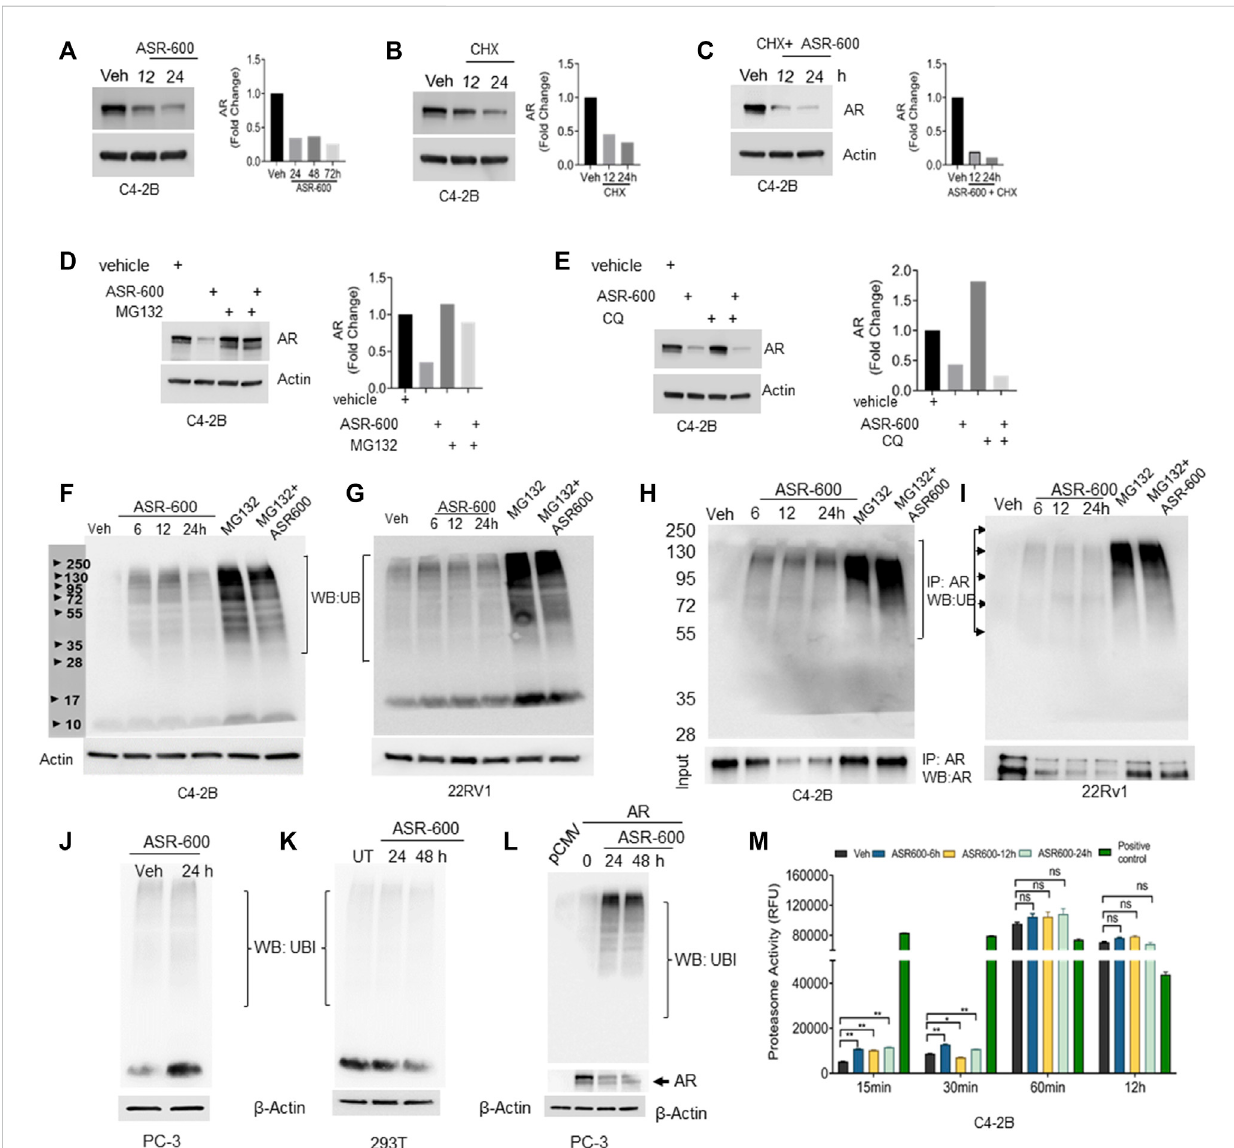
FIGURE 5 Ubiquitination of AR in ASR-600 treated CaP cells. (A – C) Immunoblots of AR expression in C4-2B cells treated with ASR-600, CHX (50 µM) or combinations at the indicated time points. (D,E) Immunoblots of AR expression in C4-2B cells treated with ASR-600, MG-132(10 µM) or CQ (50 µM), or combinations. (F,G) Immunoblots for ubiquitin protein expression in C4-2B and 22Rv1 cells were treated with MG-132, ASR-600, veh, or combinations for 6, 12, and 24 h (H,I) . Cell lysates were IP with AR antibody and subjected to WB with ubiquitin antibody. The input cell lysates were WB with AR. (J,K) Immunoblots of ubiquitin expression in PC-3 and 293T cells were treated with ASR-600 at the indicated time points. (L) PC-3 cells transfected with AR and treated with Veh or ASR600 for 0, 24, and 48 h. (M) The proteasomal activity was measured in C4-2B cells treated with ASR-600 at the indicated time